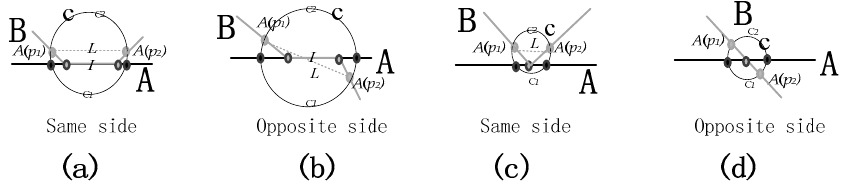
Figure 11. Comprehensive kinds of adjacent points of the intersection components between lines. ( a ) The comprehensive adjacent point kinds of intersection-line are same side; ( b ) The comprehen- sive adjacent point kinds of intersection-line are opposite side; ( c ) The comprehensive adjacent point kinds of intersection-point are same side; ( d ) The comprehensive adjacent point kinds of in- tersection- point are opposite side.